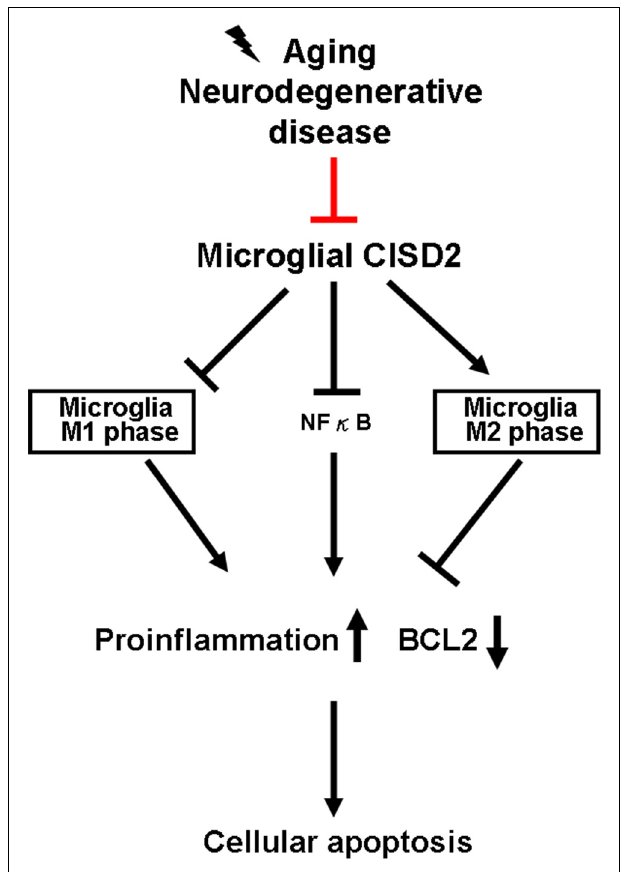
FIGURE 4 | Microglial CISD2 inhibited neuroinflammation and preserved protective microglia M2 phenotype, thereby preventing apoptosis. Microglia-driven chronic inflammation denoted pathological conditions in aging and neurodegenerative disease. Microglial CISD2 can be attenuated during the above-mentioned pathological conditions (as indicated with red bar). The decline in microglial CISD2 expression enhanced and reduced the proportion of detrimental M1 and beneficial M2 phenotype in microglia, respectively. The influence of microglial polarization exacerbated inflammation, elevated the expression of downstream proinflammatory cytokines/chemokines, and consequently augmented apoptosis as indicated by the decrease in BCL2, which potentially led to a detrimental effect on cell